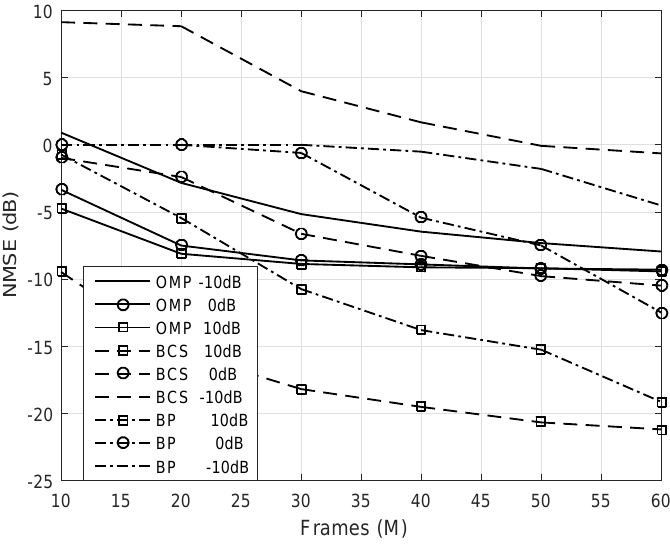
Figure 4. NMSE of the estimated CSI versus received pilot symbols with sparseness L = 5, received SNR = 10 dB, angle quantization G = 32 and without hardware